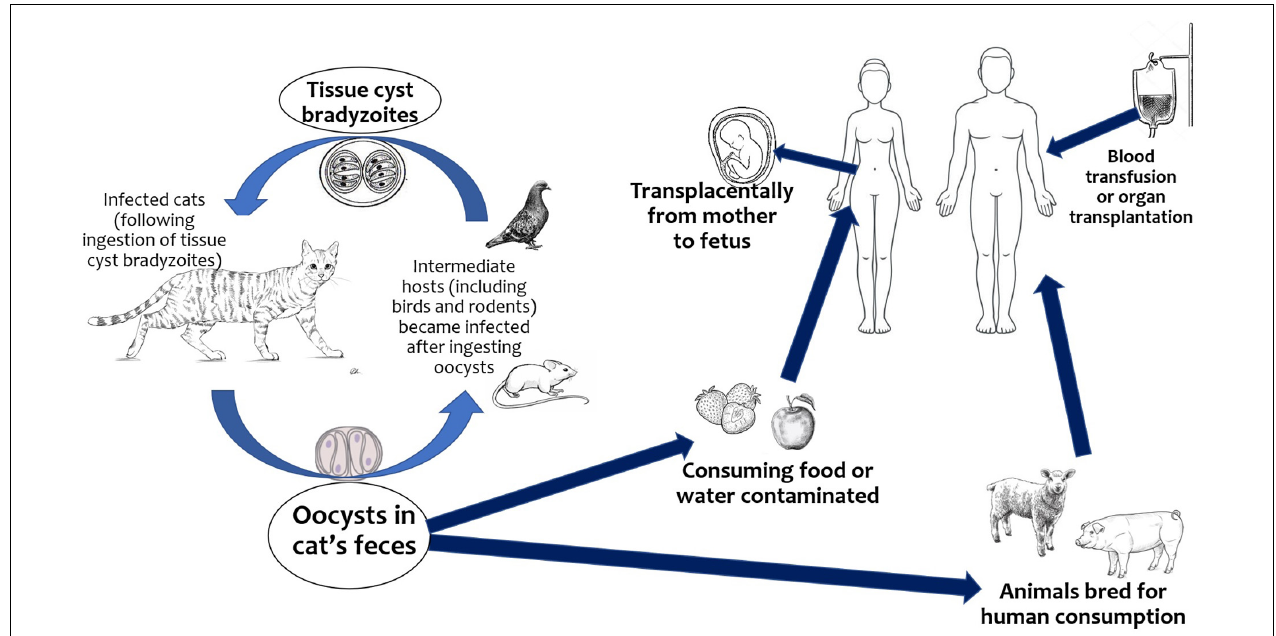
FIGURE 1 | Life cycle of Toxoplasma gondii.